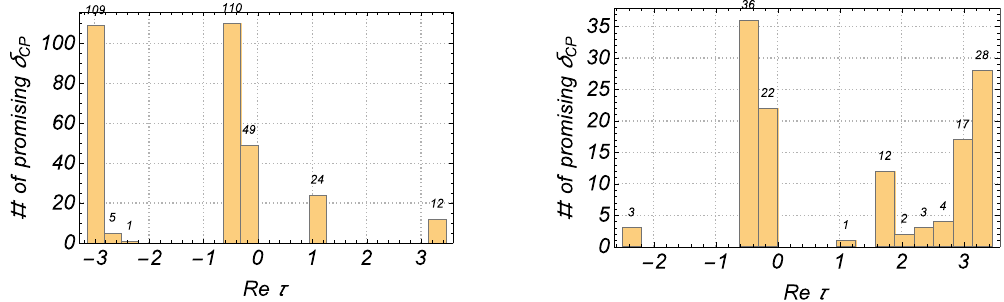
Figure 18 . Left panel: frequency of Re τ satisfying an inequality in eq. (4.8) for Im τ = 1 . 8 in Pattern V. Digits on the top of histogram bins denote the numbers of combinations of Higgs VEVs. Right panel: the same one for Im τ = 2 .